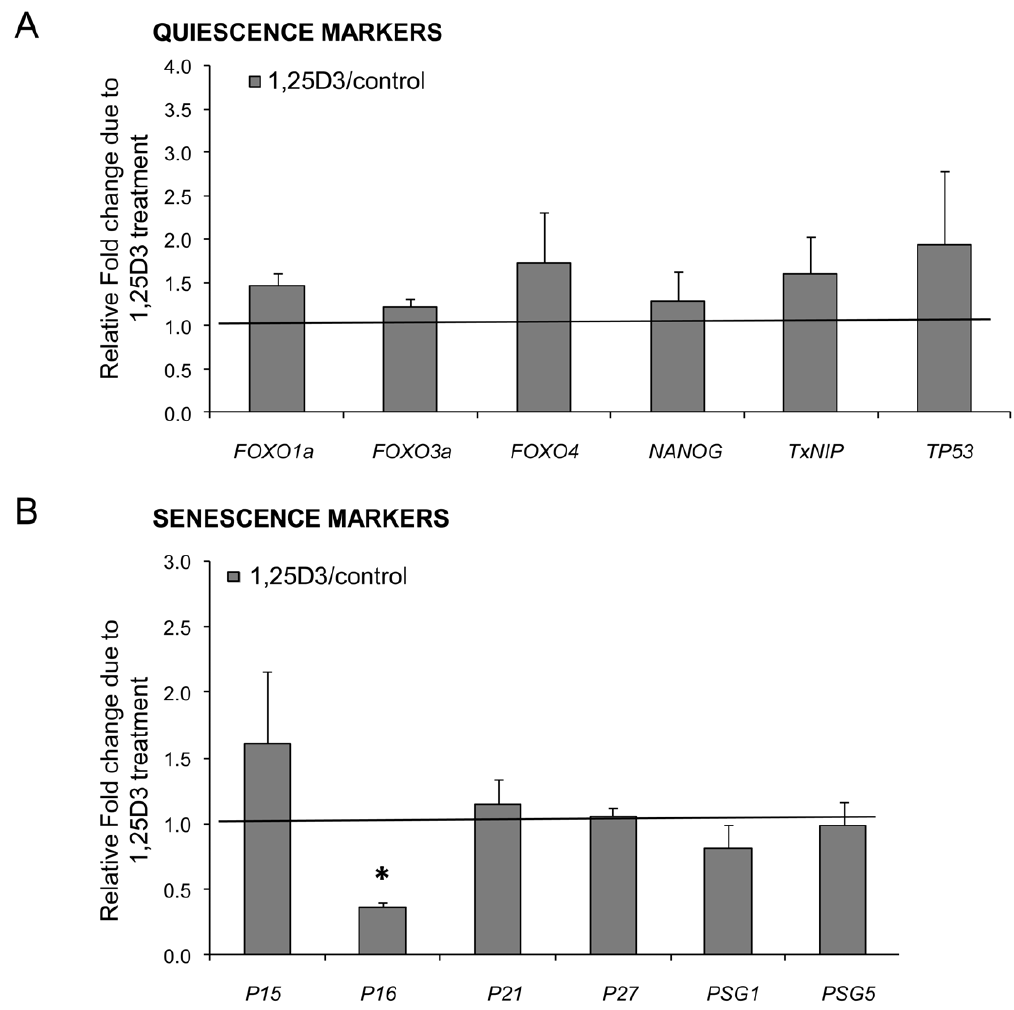
Figure 5. Effects of 1,25D3 treatment on quiescence- and senescence-associated genes. A Expression of quiescence markers and densitometric quantification of semiquantitative RT-PCR results of hMSC (P3) treated with or without 1,25D3. Cells from five different donors were used. For each donor the Fold Change was calculated by comparing the expression of 1,25D3 treated cells with control cells. The results are shown as mean + SEM. The gene expression levels of FOXO1a , FOXO3a , FOXO4 , NANOG , TxNIP , TP53 were induced by 1,25D3 treatment over 3 passages. (FOXO1a: forkhead box 1a, FOXO3a: forkhead box 3a, FOXO4: forkhead box 4, NANOG: Nanog homeobox, TxNIP: thioredoxin interacting protein, TP53: tumor protein p53). B Expression of senescence markers and densitometric quantification of semiquantitative RT-PCR results of hMSC treated with or without 1,25D3 over at least four passages. 1,25D3 treatment reduced P16 expression (p , 0.05) and induced P15 expression in cells at P4 compared to control cells. P27 and P21 gene expression in P4 showed no ( P27 ) or only very weak ( P21) induction by 1,25D3 treatment. Densitometric quantification of the semi-quantitative PCR results revealed downregulation of PSG1 and almost no change in the expression of PSG5 at P4 in 1,25D3 stimulated hMSC. The Relative Fold change represents the factor of different gene expression levels in 1,25D3 treated hMSC versus control cells. Expression profile of senescence-associated genes was determined in P4. Cells from three different donors were used. For each donor the Fold Change was calculated by comparing the expression of 1,25D3 treated cells with control cells. The results are shown as mean + SEM. (*, p , 0.05, student’s t-test).